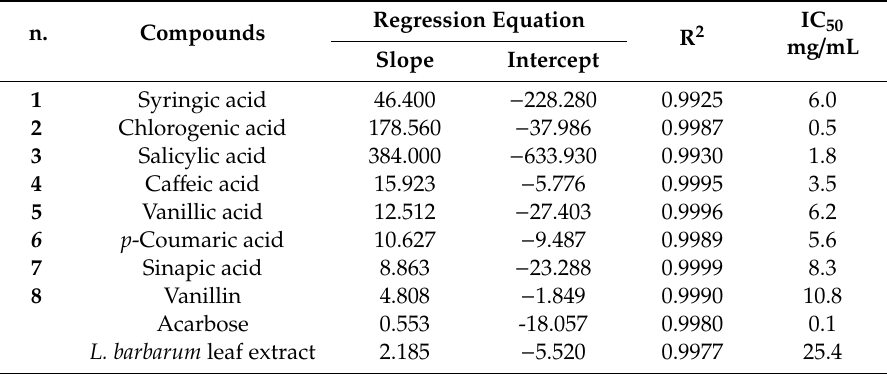
Table 2. Linear regression equations, R 2 values and IC 50 values of phenolic acids and L. barbarum leaf extract for α -amylase inhibition activity.